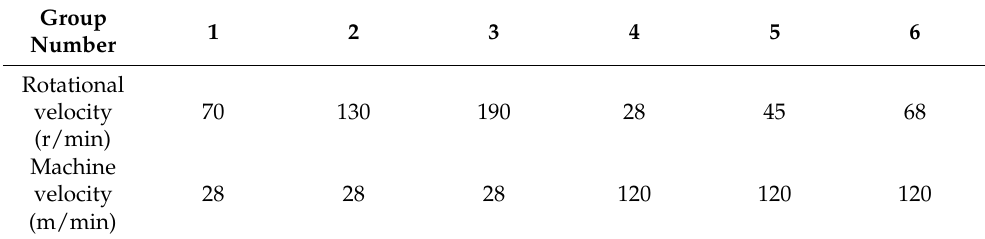
Table 3. Table of working parameters of the